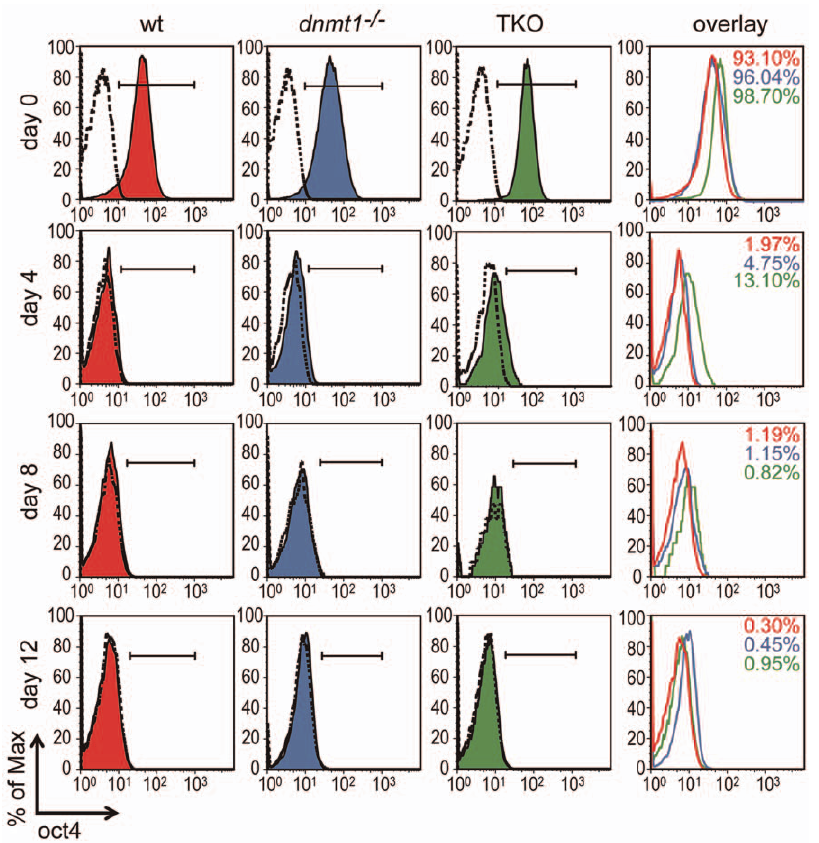
Figure 2. Uniform downregulation of Oct4 protein levels during EB differentiation. Undifferentiated ESCs colonies (day 0) and EBs at indicated stages of differentiation (day 4–12) were dissociated into single cells, stained with an Oct4 specific antibody and subjected to FACS analysis. Shaded curves depict Oct4 intracellular staining. Dashed lines indicate isotype controls and horizontal bars represent individual gates for positive Oct4 signals. The overlay shows exclusively Oct4 positive signals for each cell line. Numbers in red, blue and green indicate the percentages of Oct4 positive cells in wt, Dnmt1 2 / 2 and TKO ESCs/EBs, respectively, after subtraction of background signal from isotype controls.